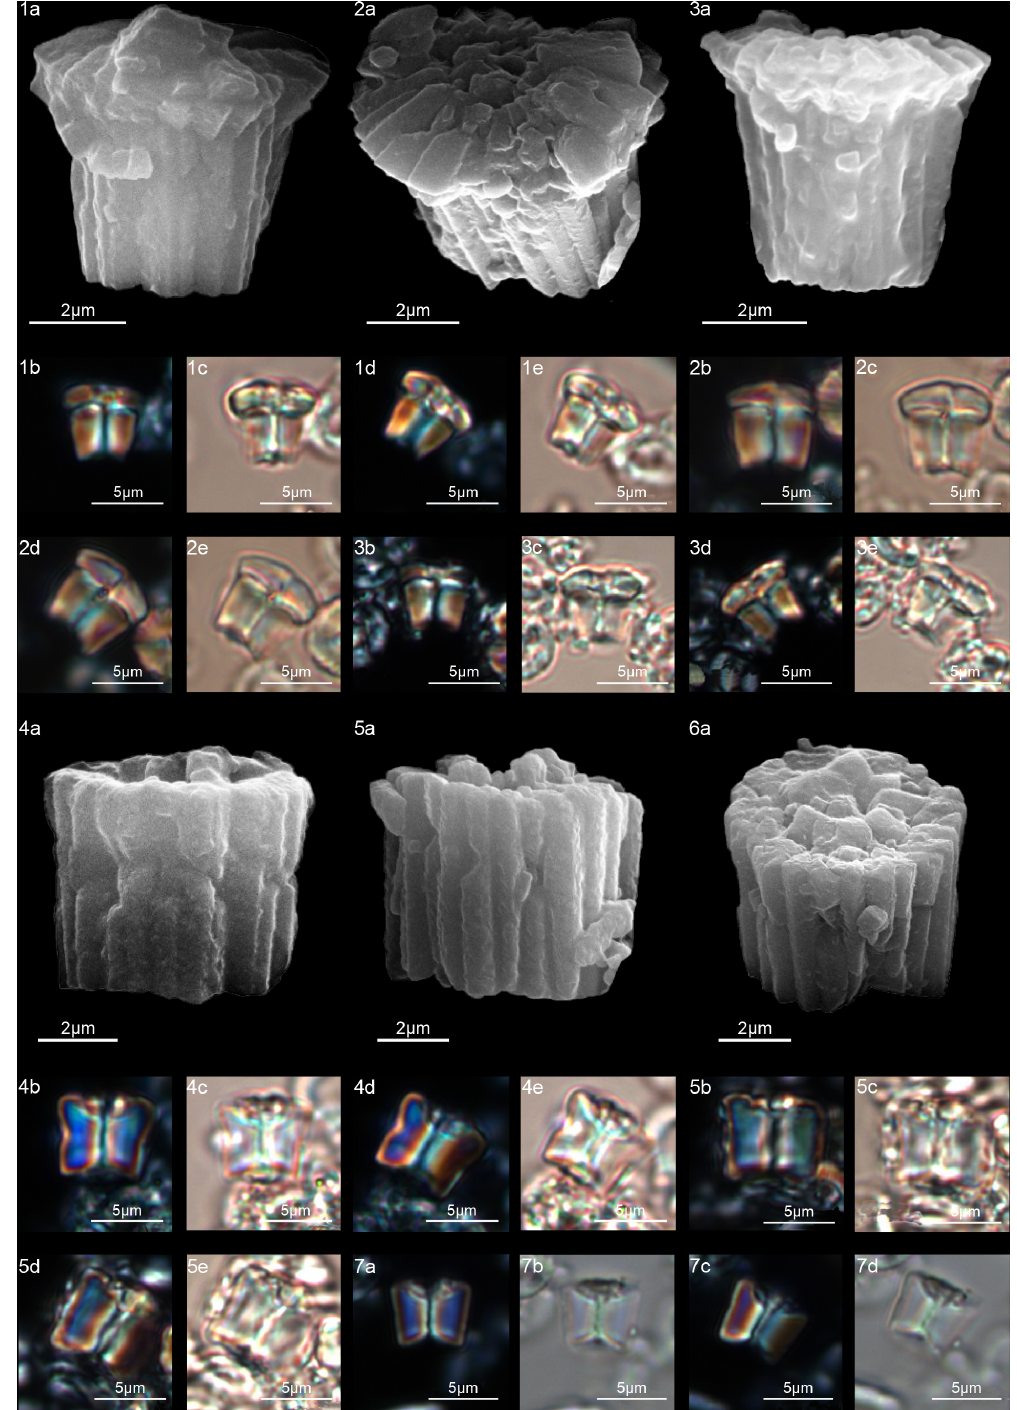
Figure 23. Tectulithus stonehengei . (1) Sample: 1262C 10-4, 131–132. (1a) SEM, (1b, d) XPL, (1c, e) PPL. (2) Sample: 1262C 10-3, 74–75. (2a) SEM, (2b, d) XPL, (2c, e) PPL. (3) Sample: 1209B 24-5, 8–9. (3a) SEM, (3b, d) XPL, (3c, e) PPL. Fasciculithus billii . (4) Sample: 1262C 10-4, 131–132. (4a) SEM, (4b, d) XPL, (4c, e) PPL. (5) Sample: 1209B 24-5, 8–9. (5a) SEM, (5b, d) XPL, (5c, e) PPL. (6) Sample: 1262C 10-3, 74–75. (6a) SEM. (7) 1262C 10-4, 131–132. (7a, c) XPL, (7b, d) PPL. See Table S1 for sample details.